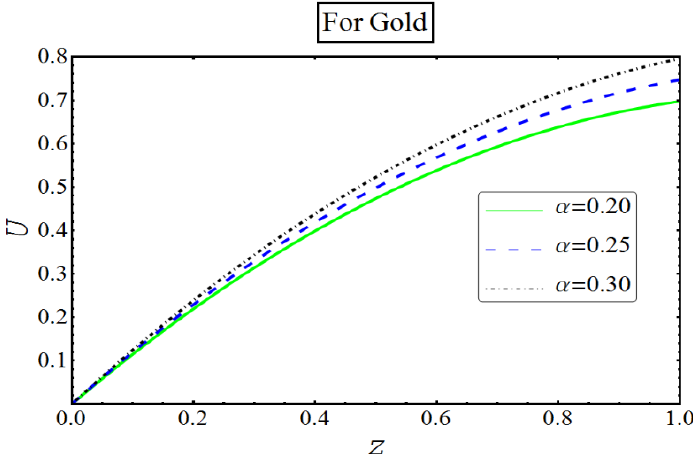
Figure 10. Behavior of radial velocity for the thermocapillary parameter comprising gold particles.